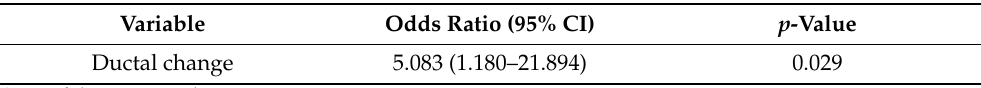
Table 6. Multivariate logistic regression analysis to determine the risk factors associated with pathologic nipple discharge in papillary breast